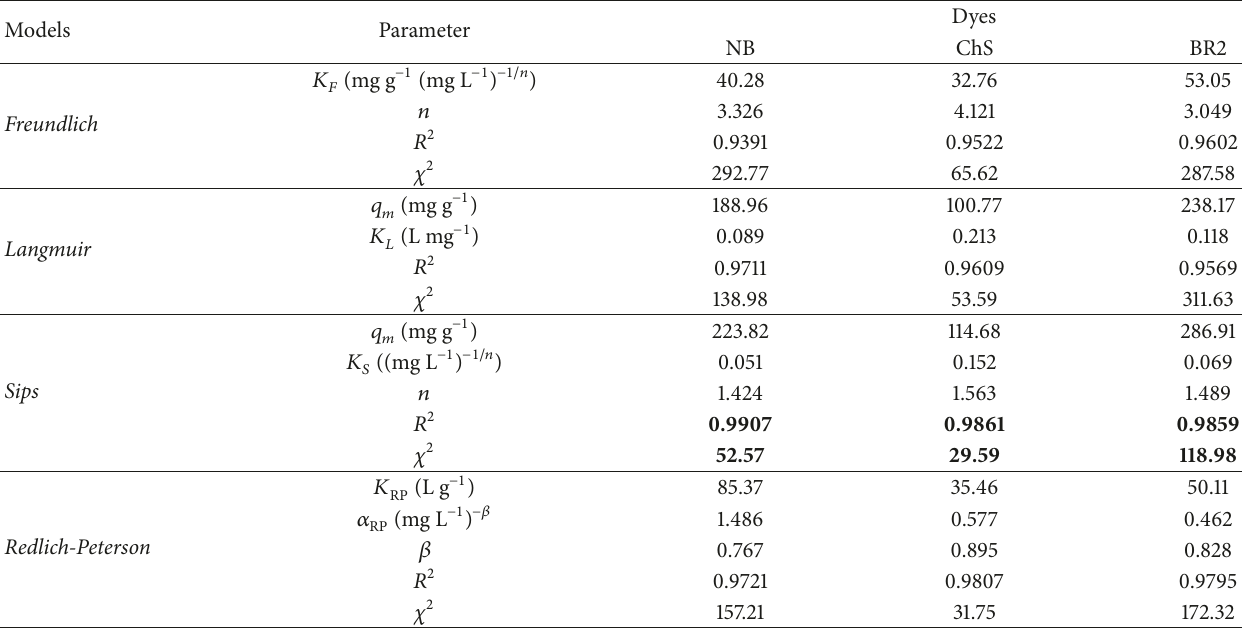
Table 5: Constants and correlation coefficients of adsorption isotherm models.